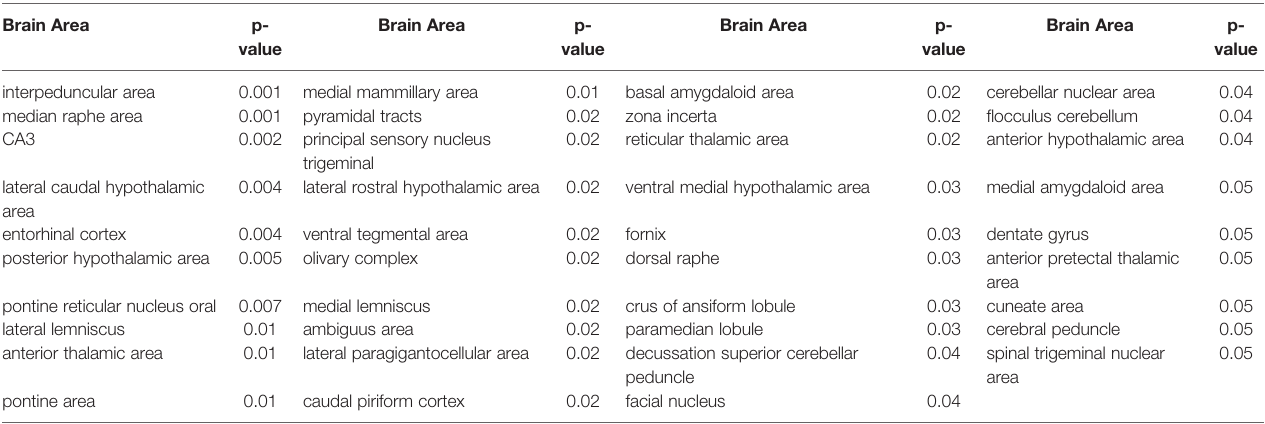
TABLE 1 | Brain regions where paclitaxel signi fi cantly increased fractional anisotropy. Brain